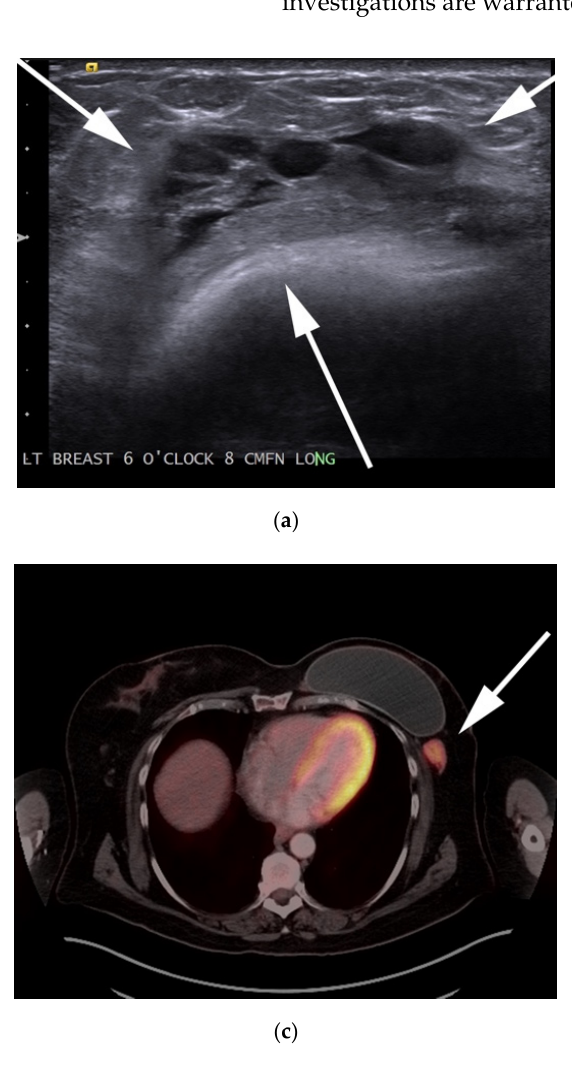
Figure 4. A 57 -year-old woman with left breast enlargement 8 years after textured implant placement. ( a ) Ultrasound of the left breast implant shows preimplant complex solid and cystic mass (two superior arrows), the inferior arrow shows echogenicity of the breast implant. ( b ) Ultrasound of the left breast shows core needle biopsy of this complex solid and cystic mass. ( c ) Axial FDG PET/CT in another 72-year-old woman who had a palpable left axillary node, F-18 FDG PET/CT axial image shows hypermetabolic left axillary node (white arrows) related to left breast implant. No preimplant masses or fluid collections seen. Both cases were biopsy-proven to be breast-implant anaplastic large T-cell lymphoma. Although ultrasound is the most sensitive modality for detecting peri-implant effusion, FDGPET/CT is essential for detecting hypermetabolic capsular masses as well as systemic disease